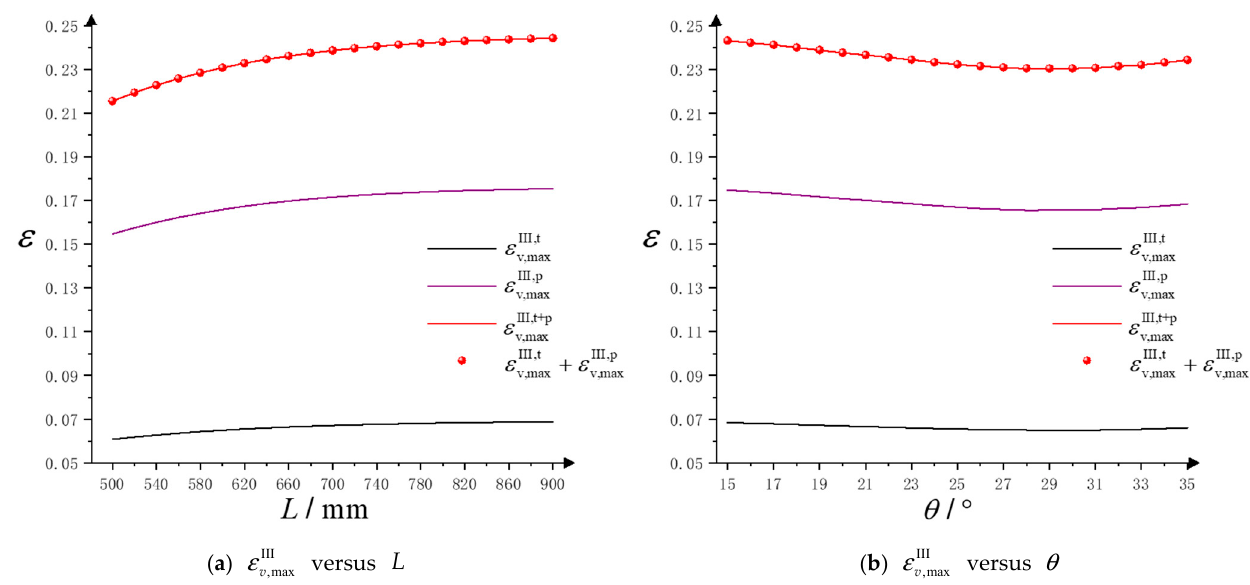
( b ) Under pressure load Figure 7. Von Mises stress cloud of the grain under different load. From Figure 7, it can be obtained that the stress cloud diagrams of the grain are ex- tremely similar when the temperature load and the pressure load are applied separately, and the locations of the danger points of each part of the grain are exactly the same, in which the danger points of grain part I and III appear near the junction point between the tail of the finocyl and the inner hole, while the danger points of grain part I appear on the central surface of the inner hole, and the maximum von Mises strains of three parts are described as